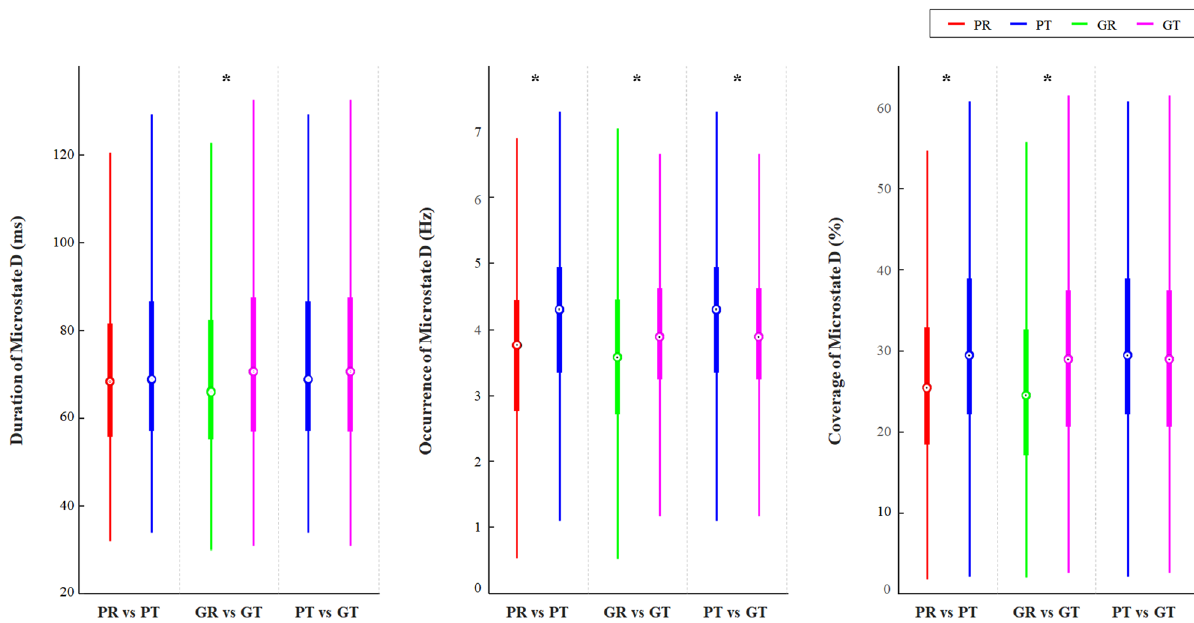
Figure 2. Changes in type D microstate features depending on task state and performance. Boxplot represents first quantile, third quantile, and the median. Group differences were tested with Mann–Whitney test. After Bonferroni–Holm correction for multiple comparisons, a significant difference is marked by an asterisk. PR poor performers in the resting state, PT poor performers in task state, GR good performers in resting state, GT good performers in task state.